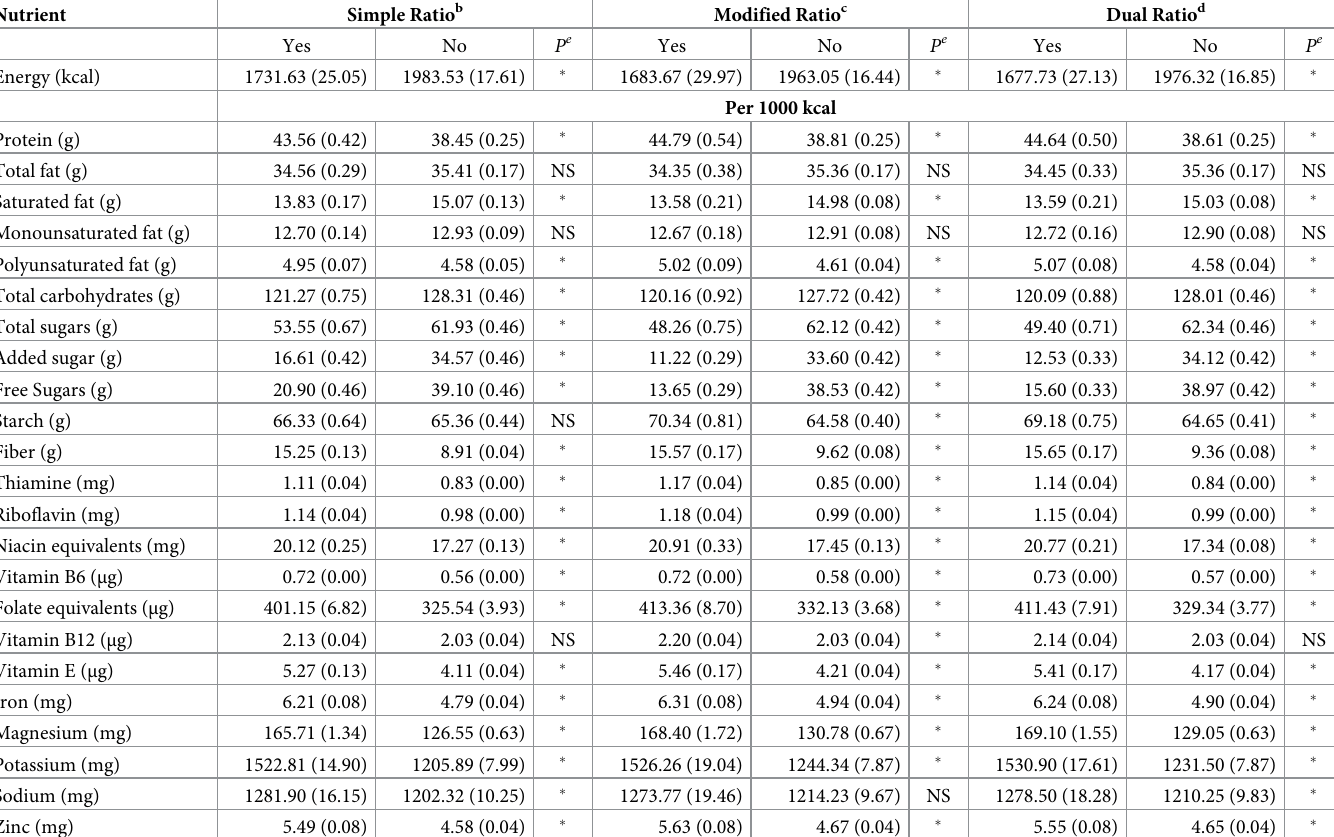
Table 4. Energy-standardised (per 1000kJ) daily macro- and micronutrient intakes for children in the 2011–12 Australian National Nutrition and Physical Activity Survey (NNPAS) who achieved or did not achieve each carbohydrate quality ratio a .